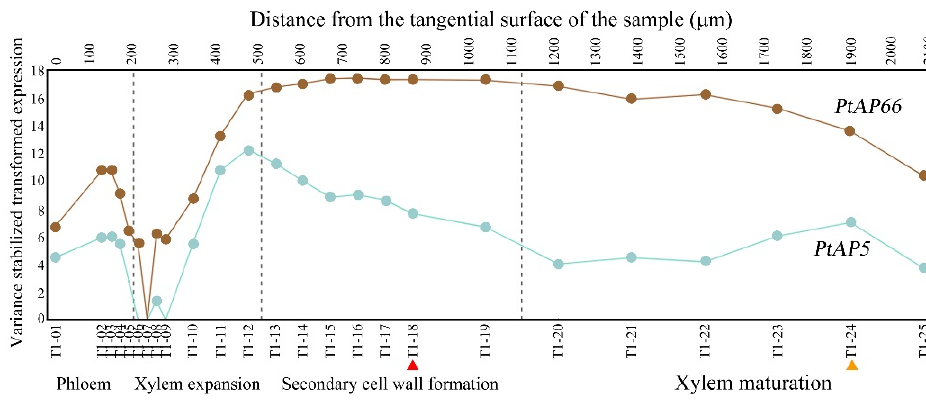
Figure 1. Expression profiles of PtAP66 and PtAP5 in Populus stem tissues.